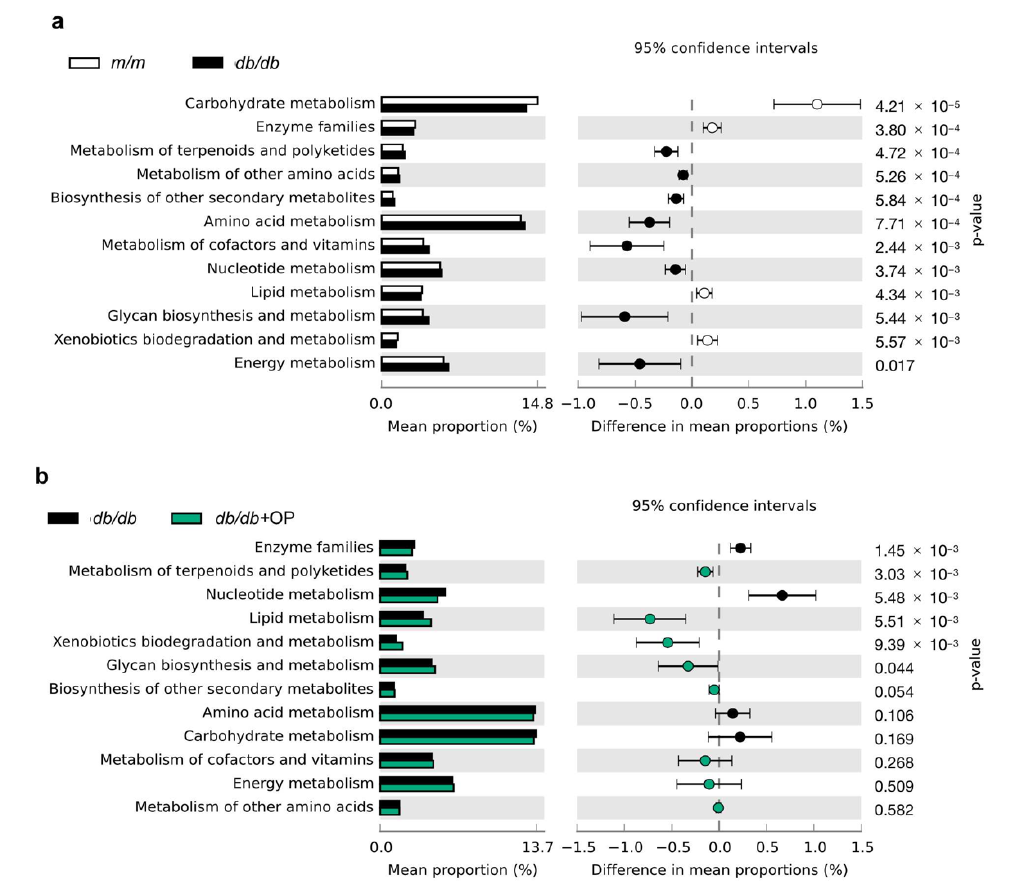
Figure 8. Predicated function of intestinal flora based on KEGG pathways. ( a ) The comparison of KEGG pathways between m / m group and db / db group mice; ( b ) The comparison of KEGG pathways between db / db group and db / db + OP group mice .